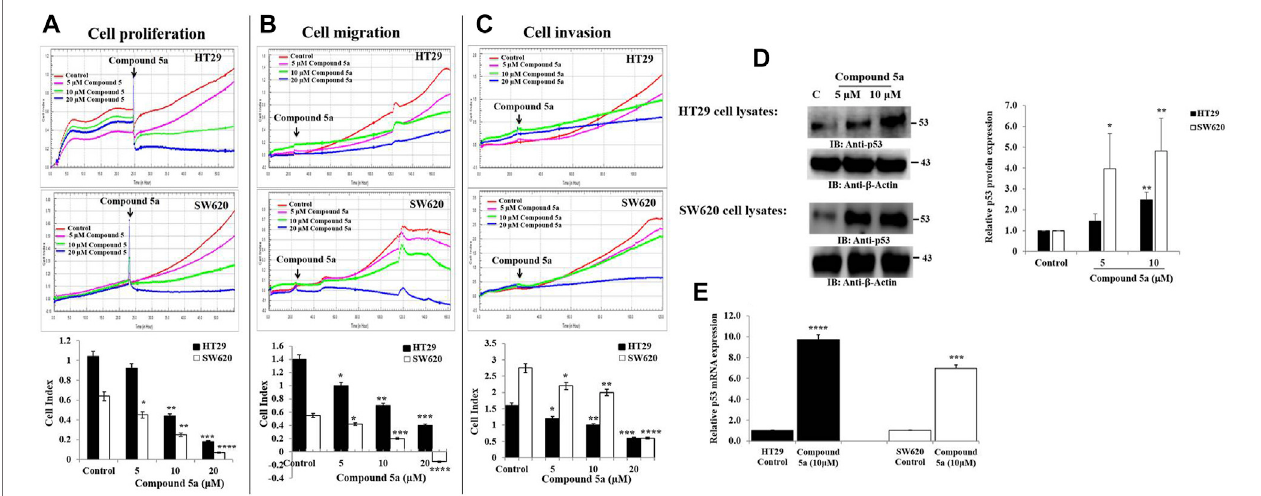
FIGURE 2 | Compound 5a inhibits adenocarcinoma HT29 and metastatic CRC SW620 cell proliferation, migration, and invasion and upregulates p53 protein and geneexpressioninbothcelllines. (A) Real-timecellproliferationwasmonitoredbymeasuringcellindexesincontrolandtreatedcellstoassesstheanti-proliferativeeffect of Compound 5a using the xCELLigenceRTCA-DPsystem. (B) Real-time cell migration and cell invasion (C) were monitored using the xCELLigence RTCA-DP system. Bar graphs showing the results expressed as mean ± SD of three independent experiments ( n = 3). (D) Total HT29 and SW620 cell lysates were immunoblotted against the protein p53 using a monoclonal anti-p53 antibody. Densitometry analysis was conducted as follows: Intensity of the protein bands was semi-quanti fi ed, normalizedtothecontrol,andplottedasrelativeproteinexpression totheloadingcontrol ß -actin.Thebargraphindicatestherelativep53protein expressionlevelasthe mean±SDofthreeindependentexperiments. (E) BargraphshowingtherelativemRNAexpressionlevelofp53relatedtotheinternalcontrolGAPDH.Dataareshownas mean ± SD ( n = 3). The data were considered signi fi cant when reporting * p < 0.05, ** p < 0.01, *** p < 0.001, and **** p < 0.0001 vs .